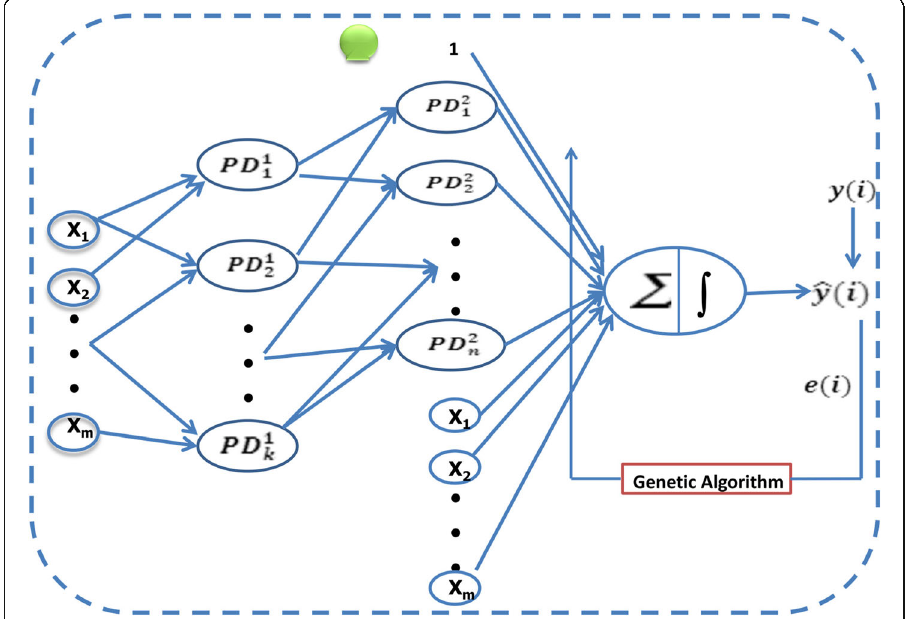
Fig. 4 Proposed Condensed PNN